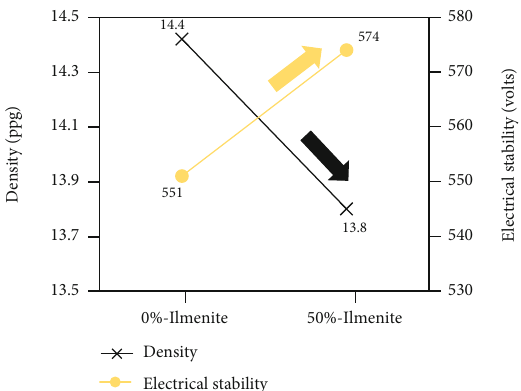
Figure 6: Mud density and electrical stability for base hematite and 50% ilmenite muds at ambient